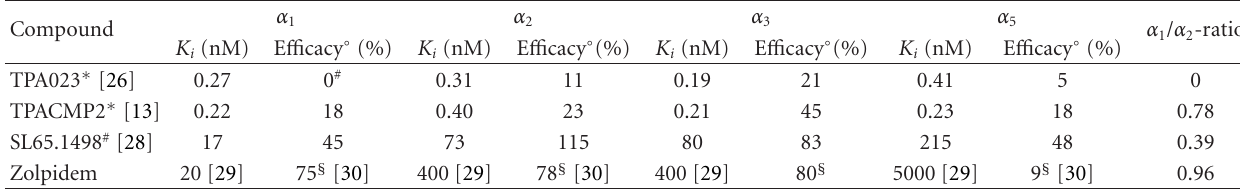
Table 1: In vitro pharmacological property of the GABAergic compounds.